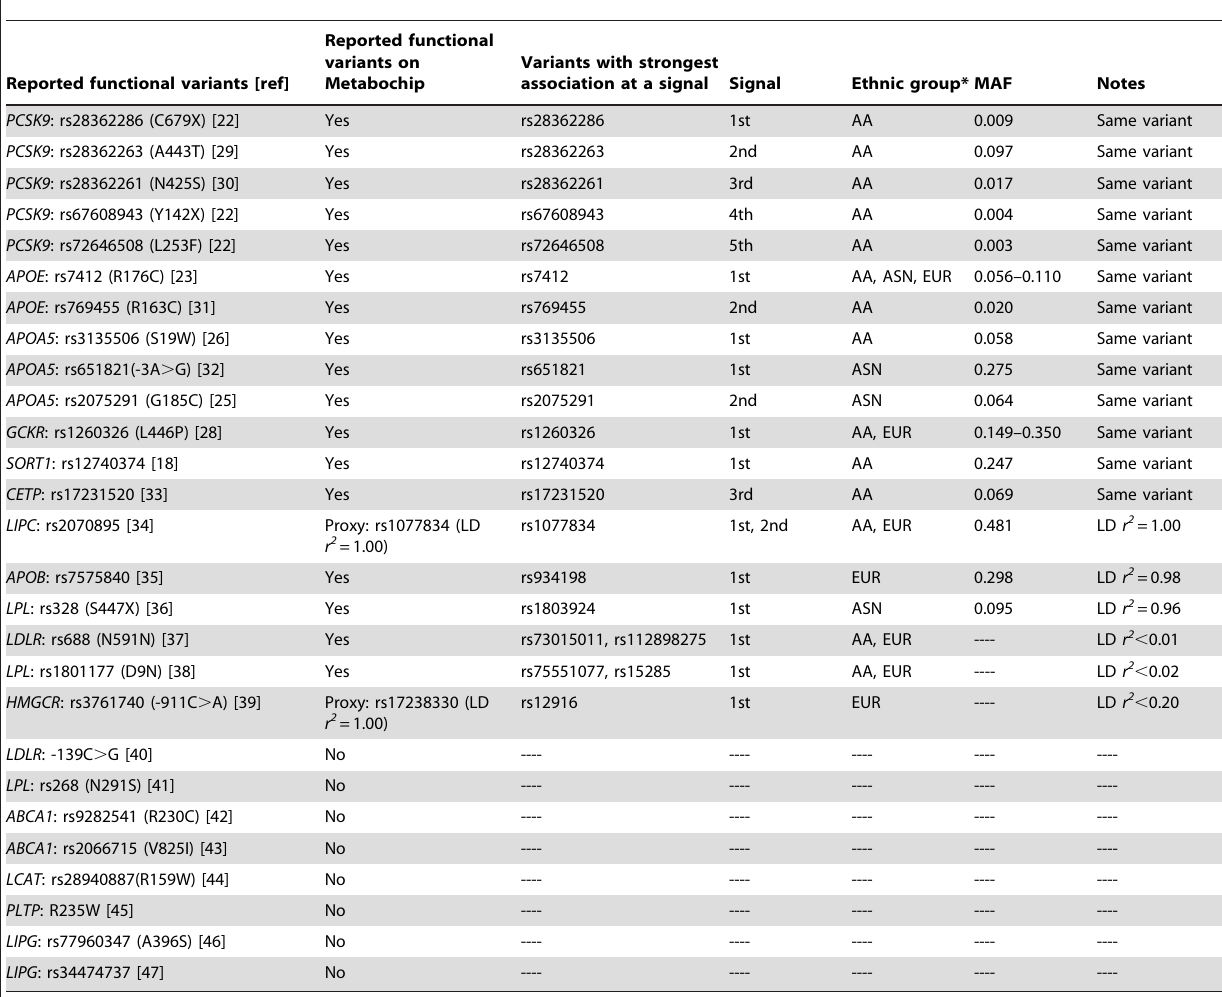
Table 5. Reported functional variants exhibited the strongest association at a signal ( P , 10 2 4